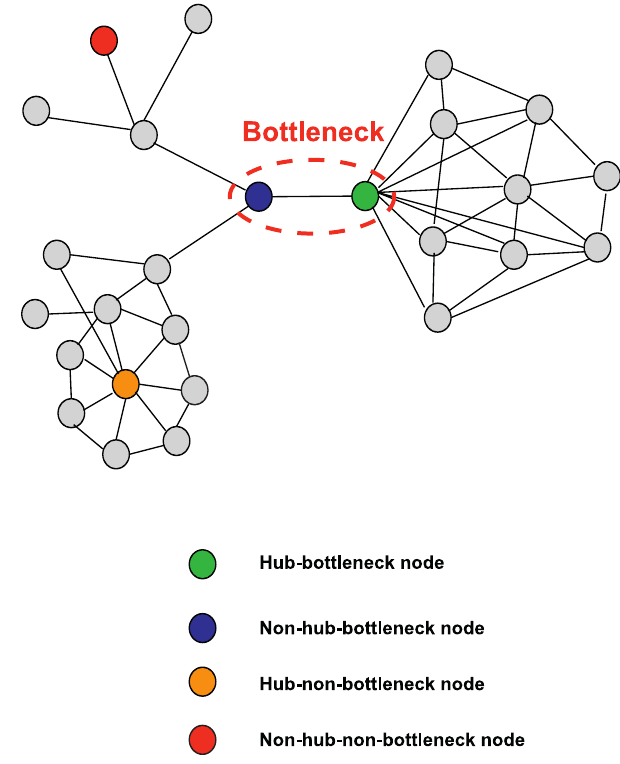
Figure 1. Schematic Showing a Bottleneck and the Four Categories of Nodes in a Network Fournodeswith differentcolors representexamplesof thefour categories defined by degree and betweenness. Please note that every node in the networkbelongsto oneof thefour categories. However,in thisschematic, we only point out the categories of the four example nodes.